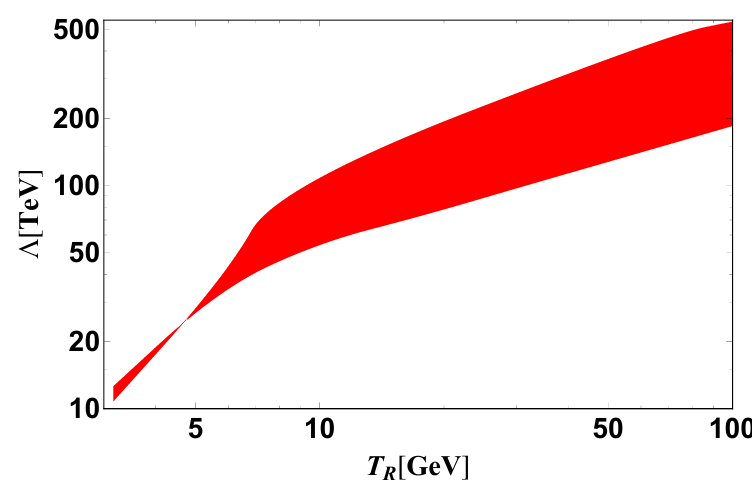
Figure 2 . The numerical result for the correct baryon asymmetry region in T R [GeV]-(cid:3)[TeV] plane. p Here 2(cid:3) = E cm , V i = 1 = 3 f exp ( i ) ; exp ( (cid:0) 2 i ) ; exp ( i ) g and C ij is randomly generated given in the main text, and B = 1. The range of the band corresponds to the variation of C 0 = [0 : 3 ;